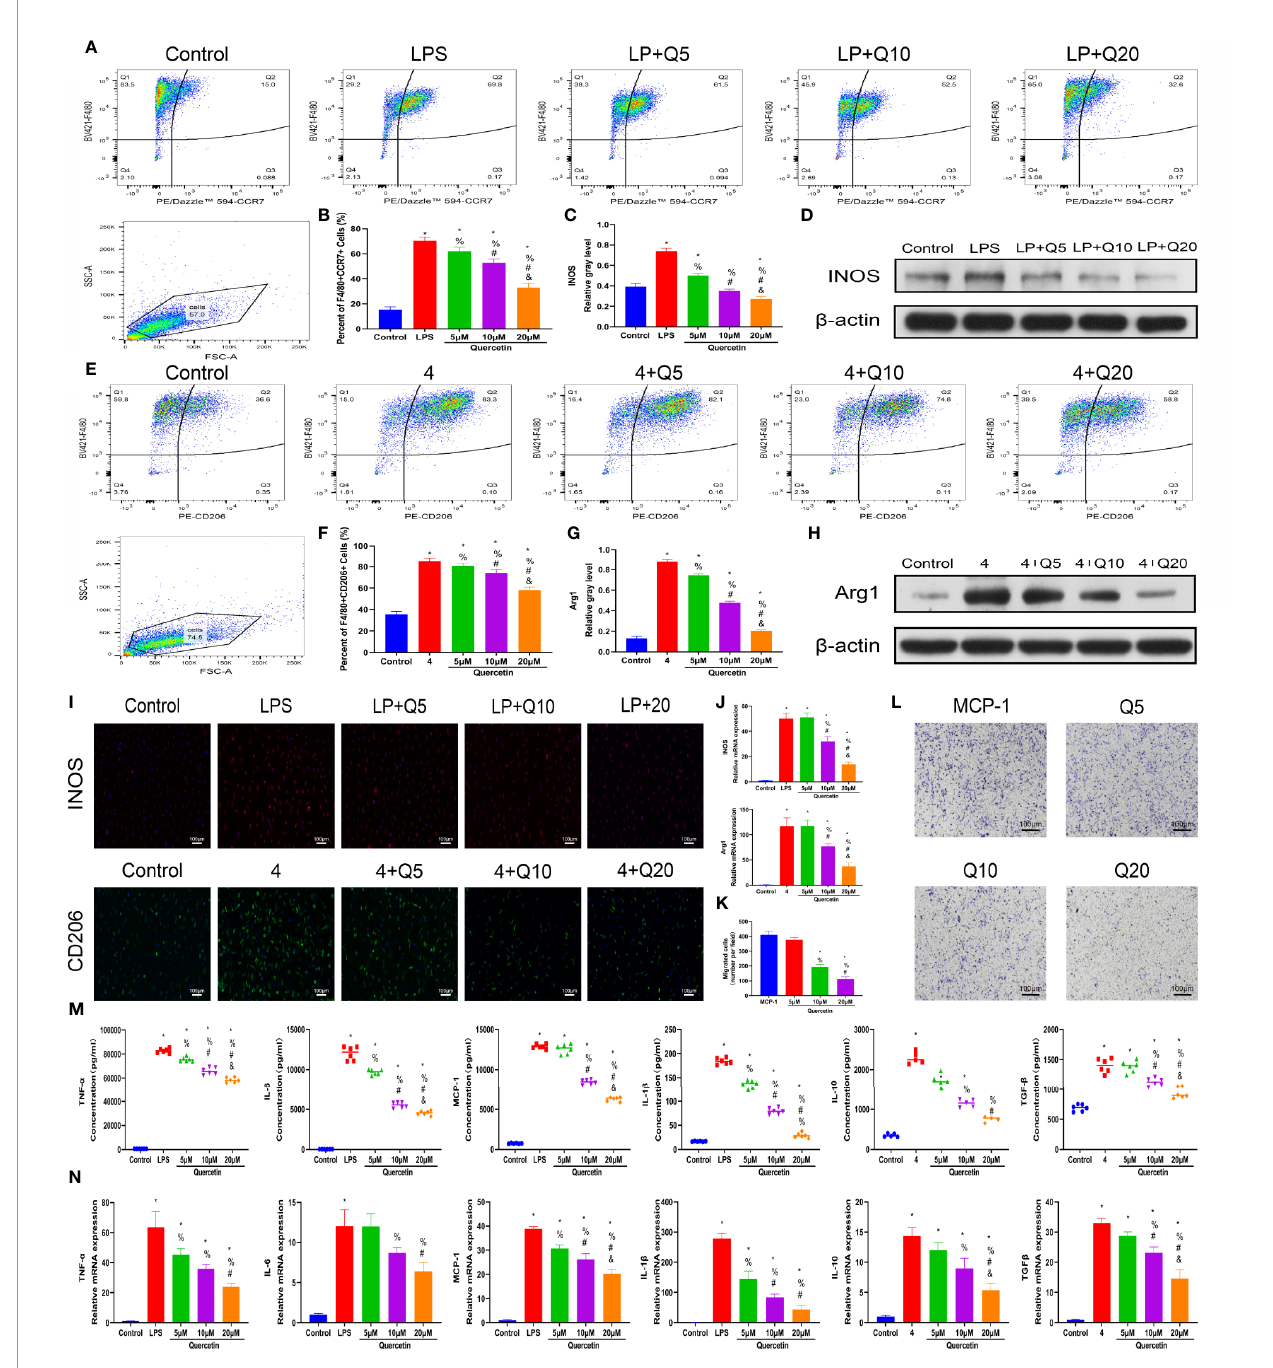
FIGURE 5 | Quercetin impaired macrophage polarization and migration in vitro . BMDMs were pretreated with quercetin for 1 h and then incubated with LPS or IL-4 for 24 h. (A) Flow cytometry analysis for F4/80 and CCR7. (B) Bar graphs illustrating the percentage of F4/80 and CCR7 double-positive cells. (C, D) The protein expression of INOS was detected by western blot. (E) Flow cytometry analysis for F4/80 and CD206. (F) Bar graphs illustrating the percentage of F4/80 and CD206 double-positive cells. (G, H) The protein expression of Arg1 was detected by western blot. (I) Immuno fl uorescence staining of INOS or Arg1. (J) The relative gene expression of INOS or Arg1 was analyzed using qRT-PCR. (K, L) Crystal violet staining of migrated BMDMs after the Transwell assay. (M) In fl ammatory cytokines in the supernatants of BMDMs upon different treatments. BMDMs were pretreated with quercetin for 1 h and then incubated with LPS or IL-4 for 8 h. (N) The relative gene expression of in fl ammatory cytokines was detected by qRT-PCR. *P < 0.05 compared with the control group, % P < 0.05 compared with the LPS or 4 group, # P < 0.05 compared with the 5 m M group, & P < 0.05 compared with the 10 m M